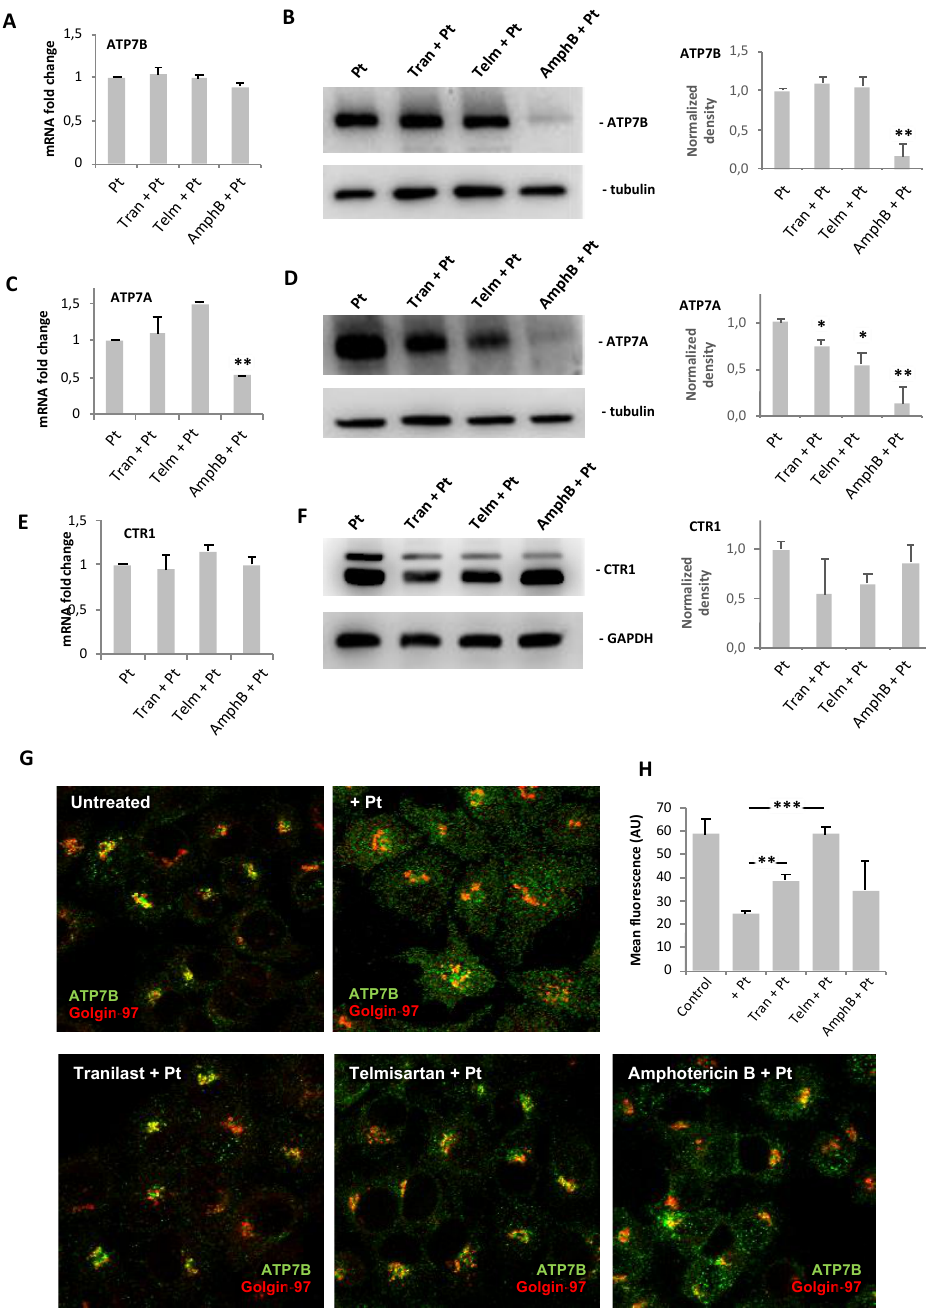
Figure 4. Impact of drug hits on expression of copper transporters and Pt-mediated trafficking of ATP7B in IGROV-CP20 cells. ( A – F ) IGROV-CP20 cells were treated with 10 µM Tranilast, Telmisartan, or Amphotericin B for 24 h and then 50 µM cisplatin was added for 24 h. The cells were then prepared for qRT-PCR (A,C,E) or Western blot ((B,D,F); see also signal density quantification in each panel) to evaluate the expression of ATP7B (A,B), ATP7A (C,D), and CTR1 (E,F) (for each qRT-PCR and blot n = 3 experiments; * p < 0.05, ** p < 0.01, ANOVA). ( G , H ) The cells were treated with 10 µM Tranilast, Telmisartan, or Amphotericin B for 24 h and then exposed to 50 µM cisplatin for 4 h to activate ATP7B trafficking. Confocal images (G) show that the drugs promote ATP7B retention in the Golgi (labeled with Golgin-97) upon cisplatin treatment as also revealed by quantification of the ATP7B signal ( H ) in the Golgi region ( n = 10 fields; ** p < 0.01, *** p < 0.001, ANOVA). Scale bar: 15 µ m ( G